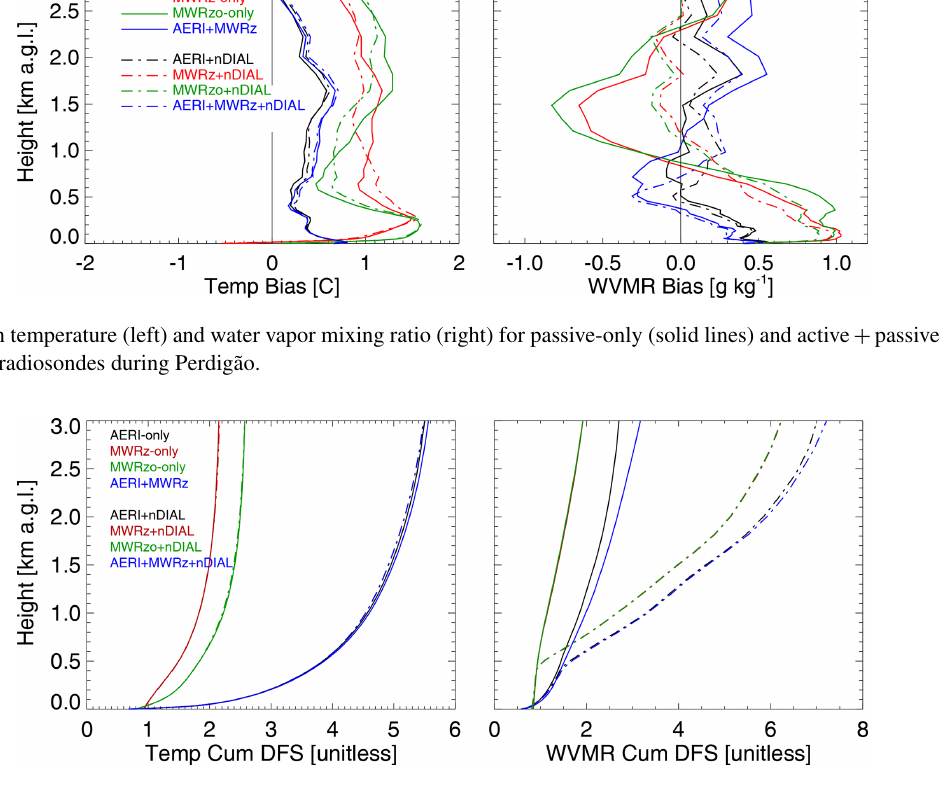
Figure 5. The mean cDFS profiles for temperature (left) and water vapor mixing ratio (right) for passive-only (solid lines) and active + passive (broken lines) retrievals during Perdigão. Note that the water vapor cumulative DFS profiles for MWRz and MWRzo retrievals are virtually identical (see Table 3) and hence